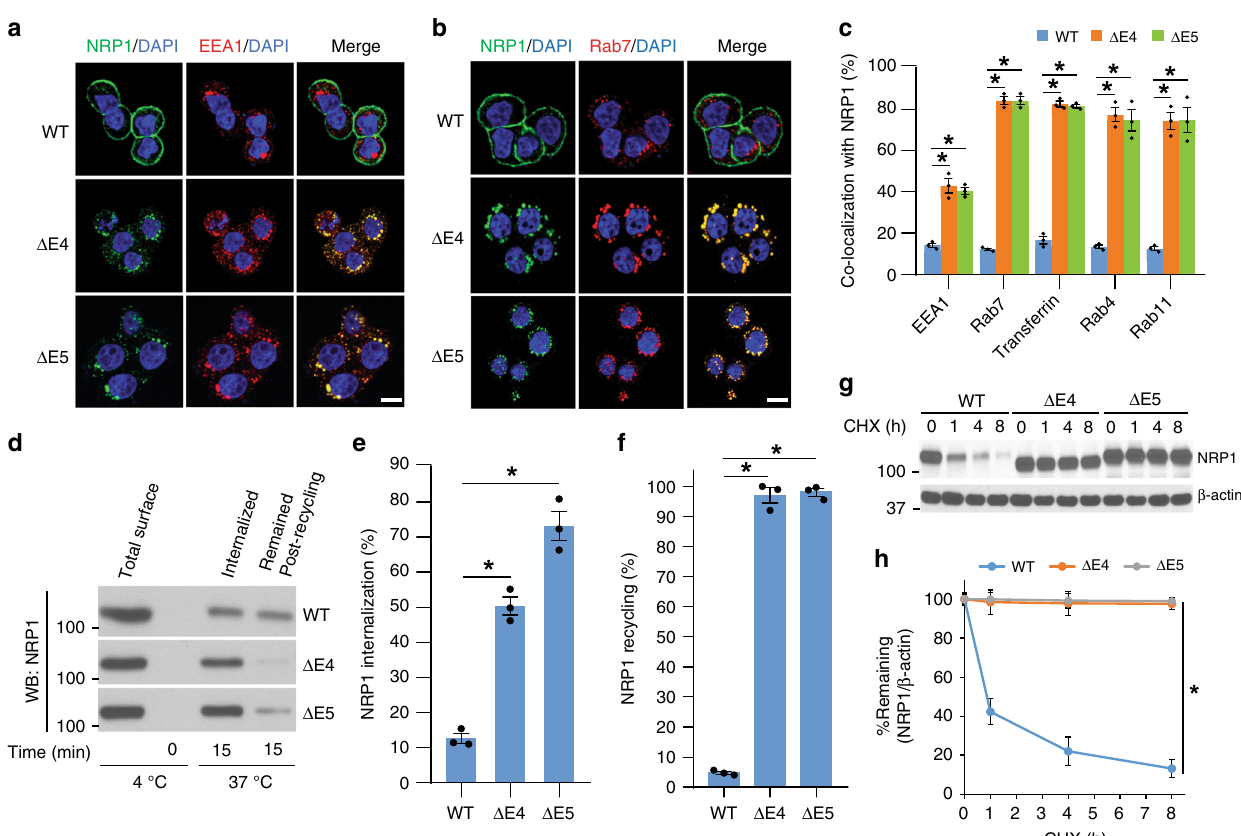
Fig. 3 The NRP1 splice variants shuttle between cell surface and endosomes and escape from degradation. a , b Confocal images of NRP1, EEA1, Rab7 and DAPI staining in HT29 cells with expression of the indicated NRP1 isoforms. Scale bars, 10 µ m. c HT29 cells with expression of the indicated NRP1 isoforms were incubated with Texas-Red-transferrin for 30 min before fi xation, and then stained for NRP1, EEA1, Rab7, Rab4 or Rab11 and DAPI (Fig. 3a, b and Supplementary Fig. 3a). The percentage of co-localization between NRP1-WT or the splice variants and endosomal markers EEA1, Rab7, transferrin, Rab4 or Rab11 was analyzed using Nikon NIS-Elements AR software. d – f Biotinylaion internalization/recycling analysis. In HT29 cells with expression of the indicated NRP1 isoforms, the levels of surface biotinylated NRP1-WT or the splice variants that were internalized (15 min) or recycled (15 min) were measured by western blot for NRP1 after streptavidin pulldown d . Quanti fi cation of internalization e and recycling f of NRP1-WT and the splice variants through densitometric analysis of bands from western blots d using Image J software. g HCT116 cells with stable expression of NRP1-WT, NRP1- Δ E4 or NRP1- Δ E5 were treated with 50 μ gml − 1 cycloheximide (CHX) for the indicated times followed by western blot analysis. h The western blots of NRP1 shown in g were quanti fi ed using Image J software. The level of NRP1 remaining was obtained by normalizing to the β -actin level at each time point. All graphic data are presented as mean ± s.e.m. ( n = 3 independent experiments). * p < 0.001 using Student ’ s t